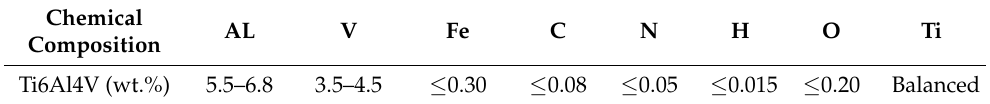
Table 2. Ti4Al6V mechanical properties.